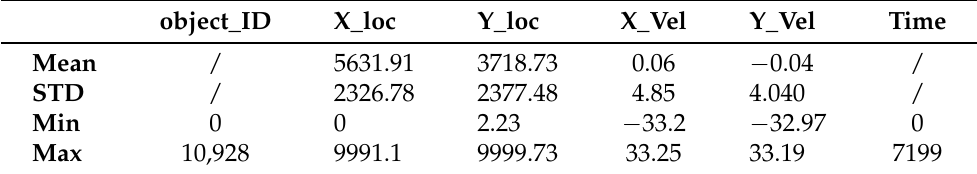
Table 3. Summary of Dataset.